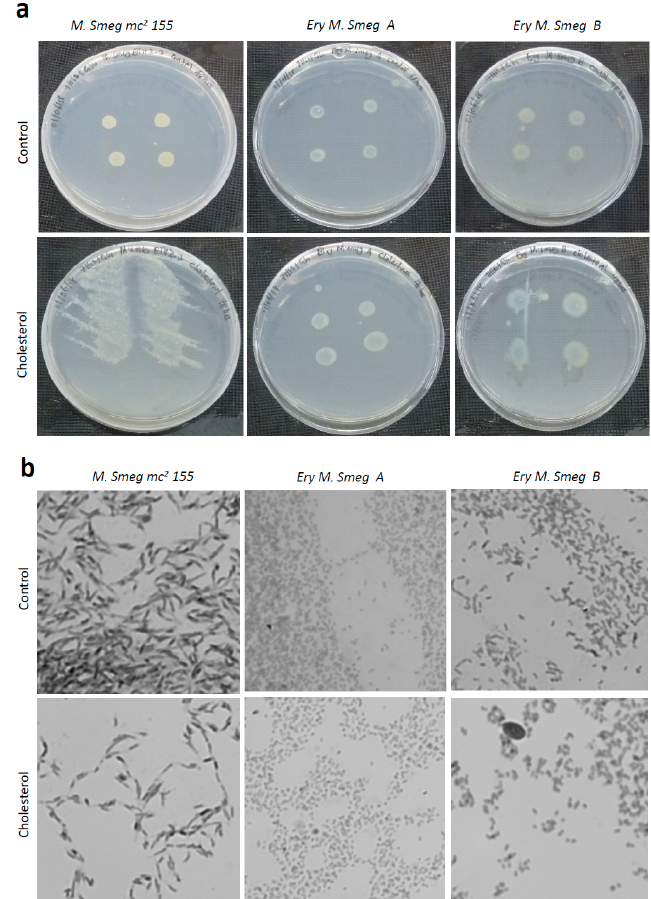
Figure 6. Effect of cholesterol on the morphology of colonies and individual cells of the drug-susceptible and MDR Mycobacterium smegmatis strains. ( a ) Colony morphology of the three Mycobacterium smegmatis strains in the absence and presence of cholesterol. Overnight cultures of the three strains were diluted to an OD 600 of 0.7, and aliquots of 5 µ L were spotted at four positions on M7H10 agar plates containing 100 mM cholesterol, as well as M7H10 agar plates that did not contain cholesterol (control). The plates were incubated for 48 h at 30 ◦ C. ( b ) Visualization of individual cells from the mycobacterial colonies on the M7H10 agar plates, shown in ( a ). Ery M. smeg A and Ery M. smeg B represent the two erythromycin-resistant clones derived from the Mycobacterium smegmatis mc 2 155